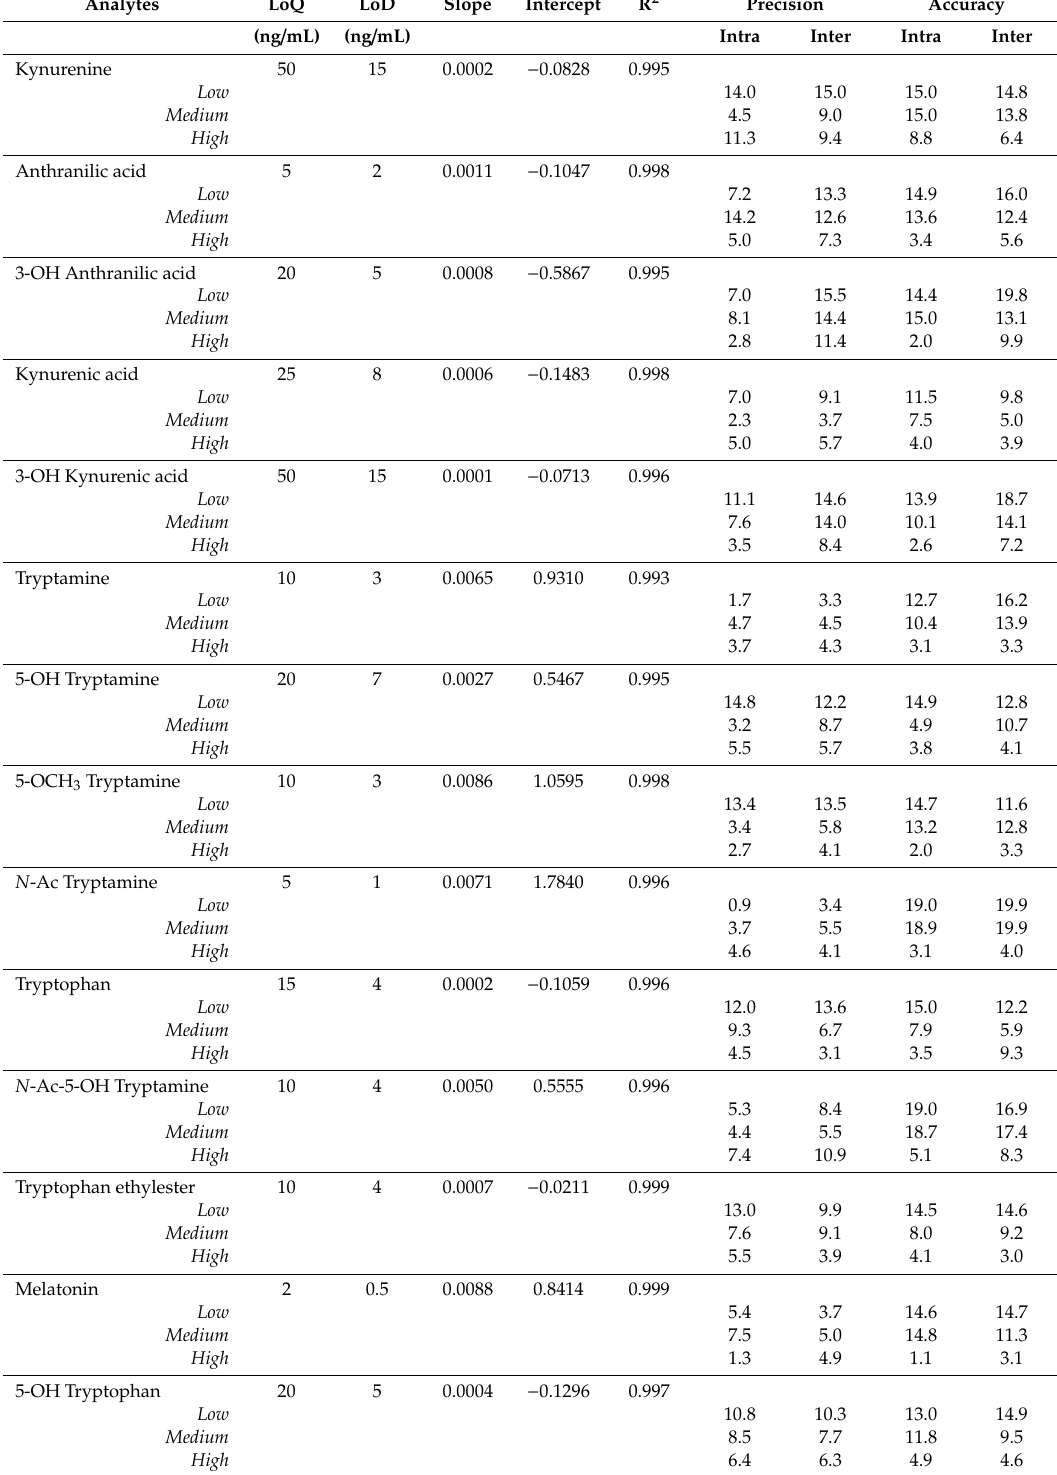
Table 2. Analytical performances. Some relative error (RE%) values (in bold) were > 15%, but were still considered suitable for our